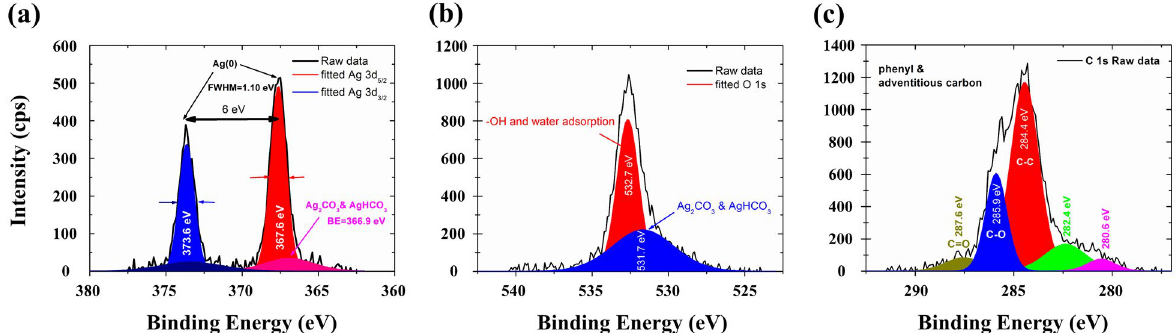
Figure 2. X-ray photoelectron spectroscopy of ( a ) Ag 3d, ( b ) O1 s , and ( c ) C1 s states on the surface of the as-metallized PET fabric. Fitting is carried out using software CasaXPS which is detailed in Methods.